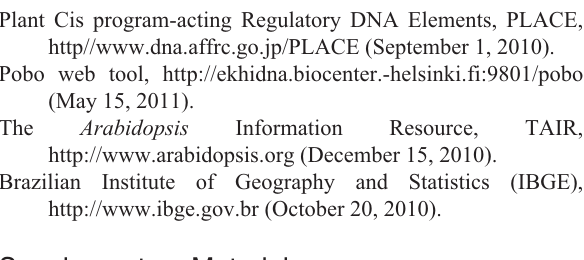
Table S1 - Cis-regulatory element responsive to drought stress, salinity stress, osmotic stress and ABA. Table S2 - Frequency of the cis -elements present in promoters of the DMGs. Figure S1 - Search strategy for DMGs involved in the soybean response to water deficit. Figure S2 -Digital expression pattern of Arabidopsis DMGs involved in the response to different water